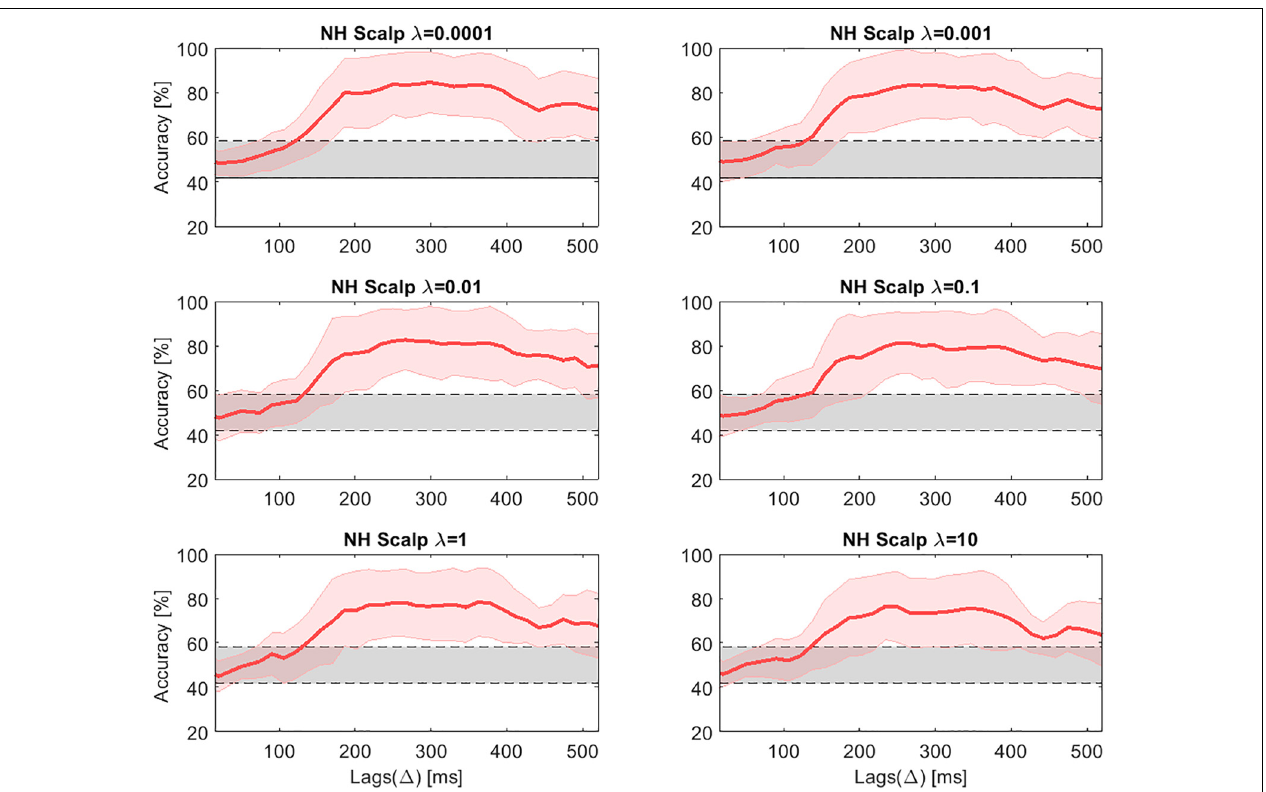
FIGURE 6 | Decoding accuracies in NH listeners for the high-density scalp EEG data across lags for different values of the regularization parameter λ . The gray shaded areas show the chance